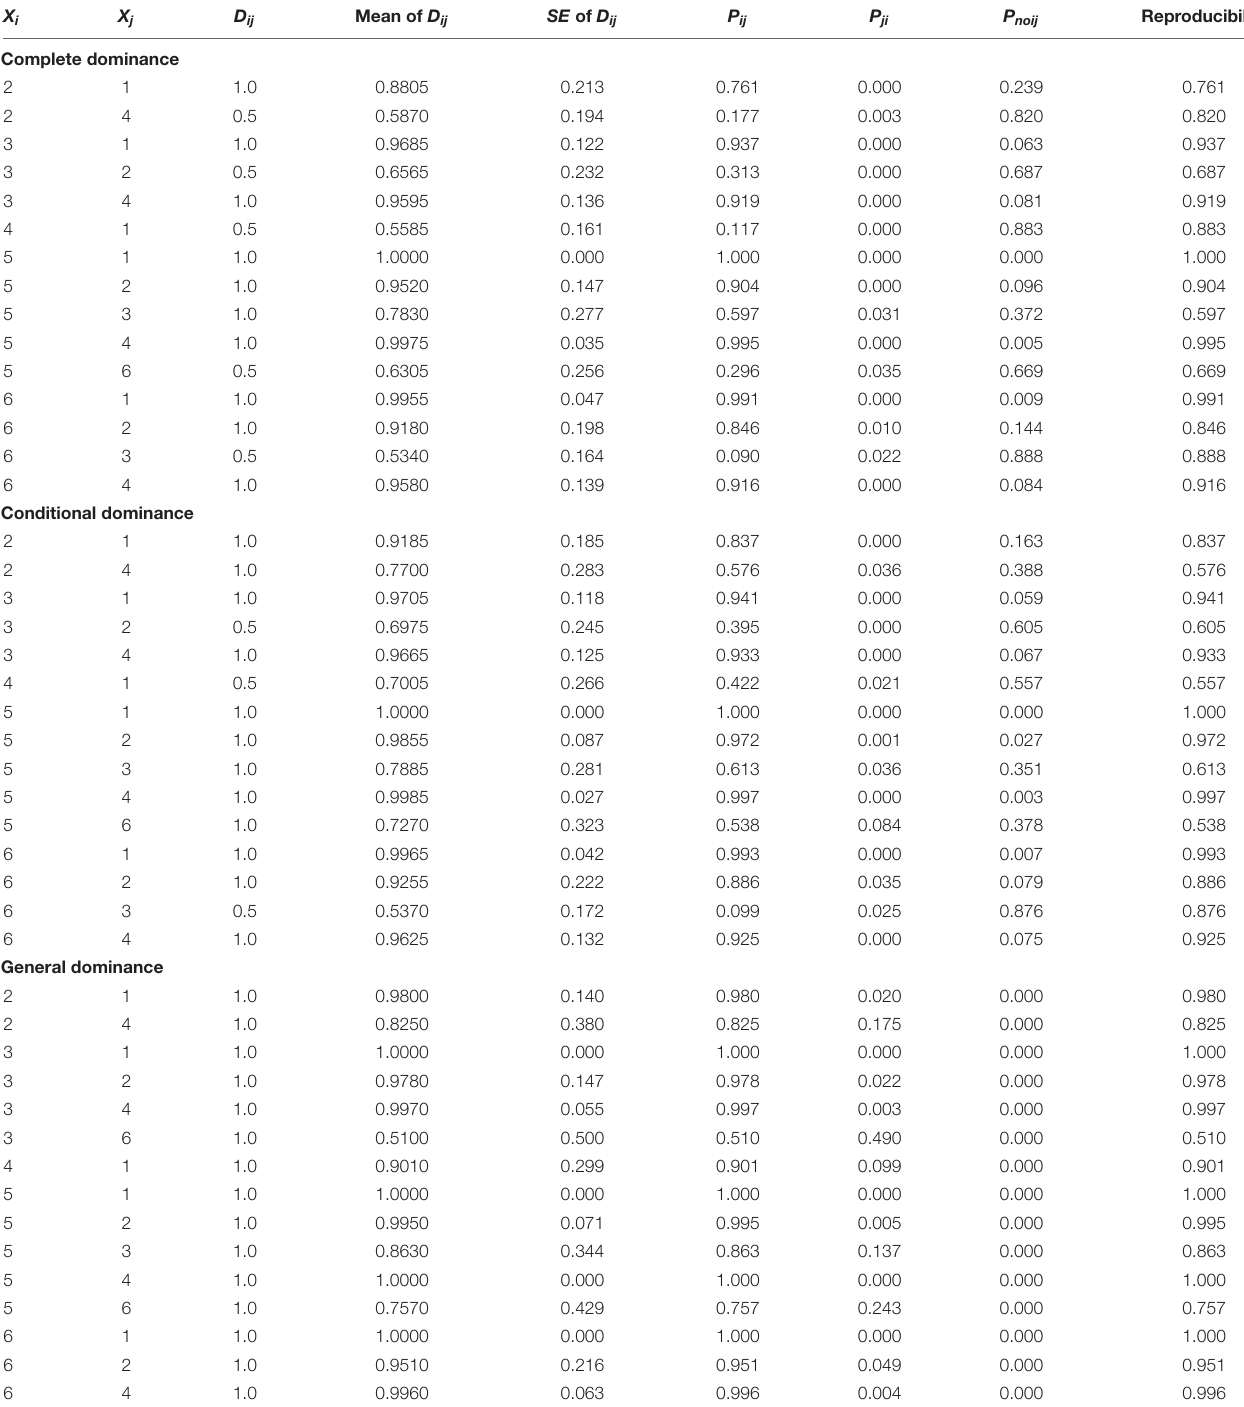
TABLE 3 | Dominance values in the sample ( n = 294) and their means, standard errors, probabilities, and reproducibility over 1,000 bootstrap